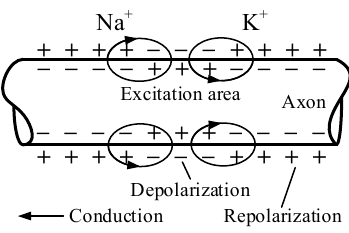
Figure 3. Transmission of action potential.